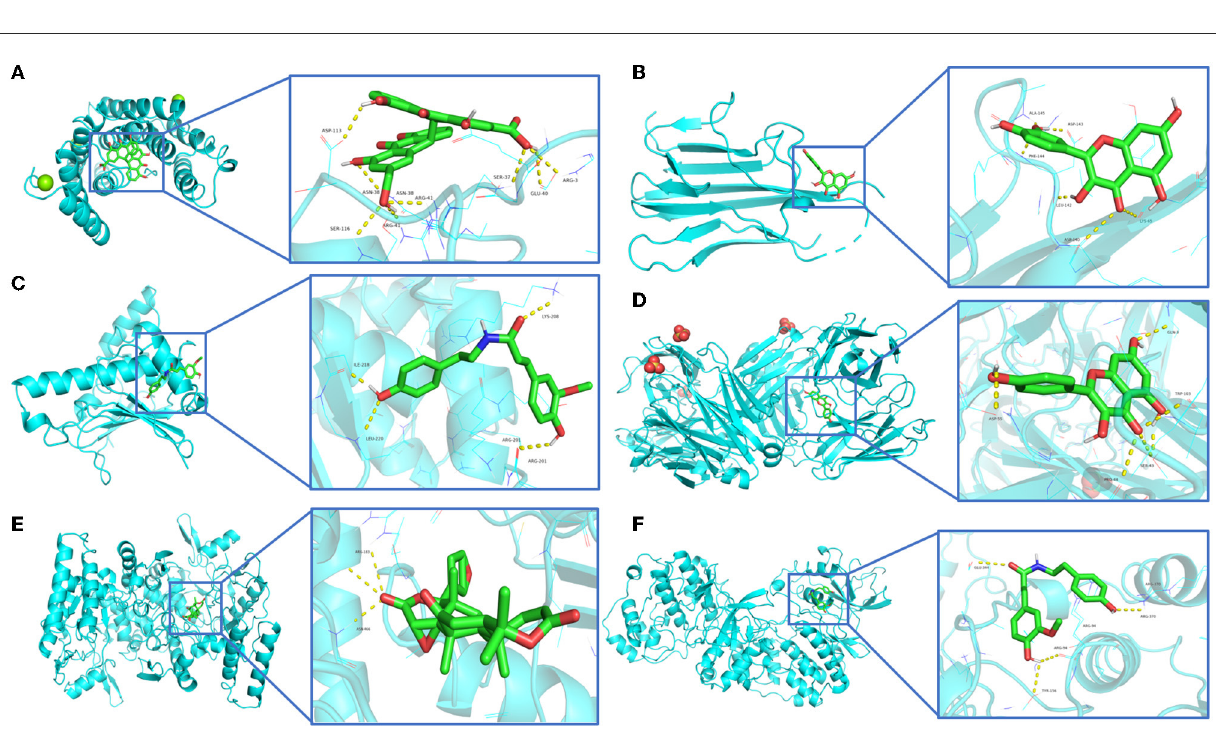
FIGURE8 Molecular and key target docking verifications. (A) Sennoside E_q-ESR1, (B) Quercetin-TNF, (C) Moupinamide-HSP90AA1, (D) Kaempferol-CAV1, (E) Obacunone-NOS3, (F)